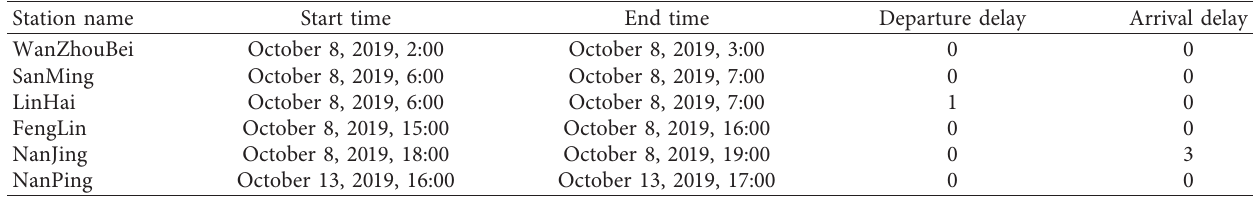
Table 8: The total number of delayed trains at a station in a certain period of